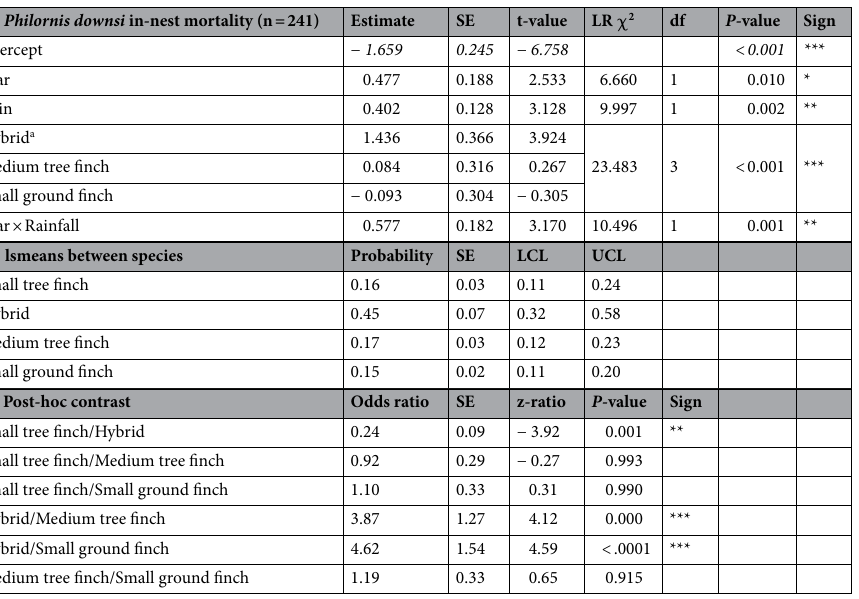
Table 3. Generalized linear model for (a) avian vampire fly ( Philornis downsi ) in-nest mortality in relation to year and rainfall (interaction term) and species; (b) lsmeans (least squares means; extracted with the ‘emmeans’ package) and (c) post-hoc contrasts for vampire fly in-nest mortality between Darwin’s finch species. Avian vampire flies collected from Darwin’s finch nests in 10 sampling years across a 17-year period (2004–2020) on Floreana Island. a Species ‘small tree finch’ was used as a reference category. × indicates an interaction term Dispersion Parameter for quasibinomial family taken to be 12.381. Intercept presented in italics. Sign = significance levels: ‘***’ < 0.001; ‘**’ < 0.01; ‘*’ <0.05; lsmeans intervals are back-transformed from the logit scale and post-hoc contracts were performed on the log-odds ratio scale following the tukey method.